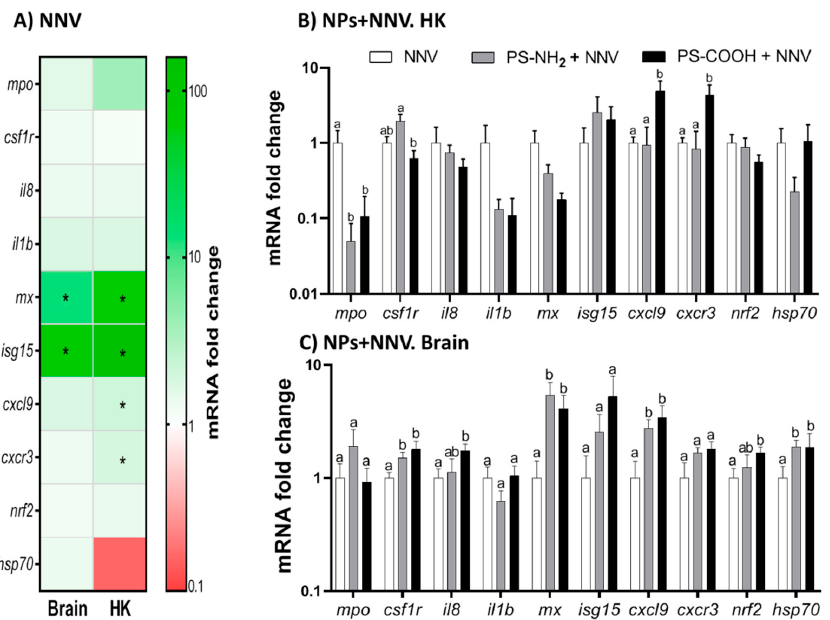
Figure 4. Exposure to functionalized nanoplastics (NPs) differently alters the transcription in- duced by nervous necrosis virus (NNV). European sea bass juveniles were intraperitoneally injected with phosphate buffer (PBS; Control) or with 1 µ g mL − 1 of 50 nm functionalized polystyrene NPs (PS-NH 2 and PS-COOH) and 96 h later challenged with NNV by intramuscular injection and analysed by real-time PCR three days h post-infection. ( A ) Heatmap of the transcriptional profile in the brain and head-kidney (HK) of sea bass challenged with NNV. Data are presented as the mean mRNA fold-change of the relative gene expression in NNV-infected specimens compared to mock- infected ± SEM ( n = 6). Asterisks denote significant differences between groups (Student-t test; p < 0.05). Transcriptional profile in the head-kidney ( B ) and brain ( C ) in NP-exposed and NNV-chal- lenged fish. Data are presented as the mean mRNA fold-change of the relative gene expression in NP-exposed and NNV-challenged specimens compared to those only challenged ± SEM ( n = 6). Lowercase letters indicate significant differences between treatments according to ANOVA and Tukey’s post-hoc tests ( p <